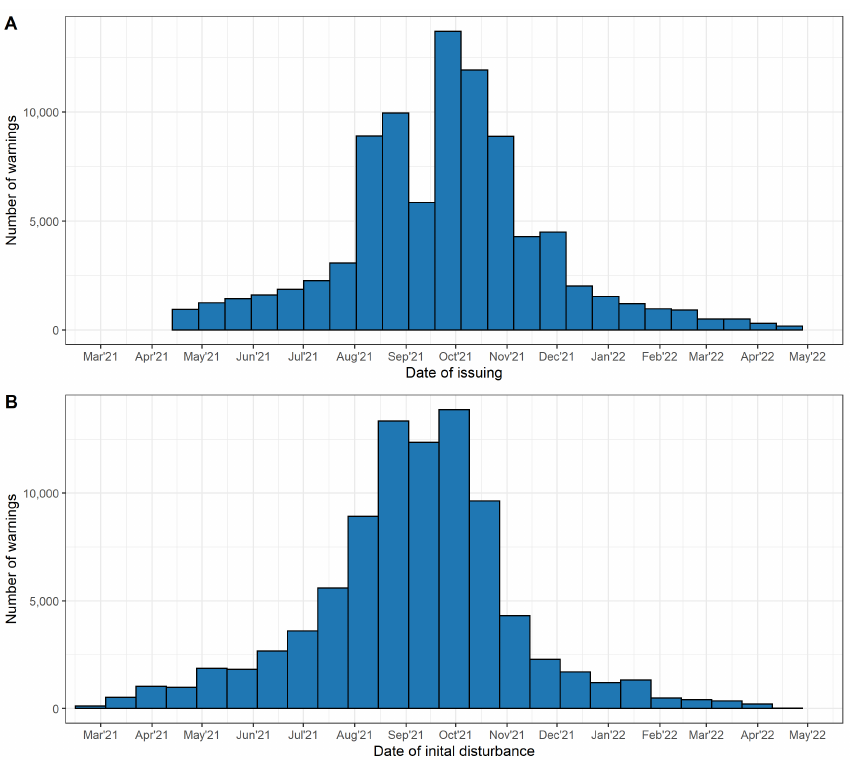
Figure 12. Timeline of the DETER-R detections. ( A ) The horizontal axis represents the date when the warning was issued ( B ) The horizontal axis represents the date of the detected